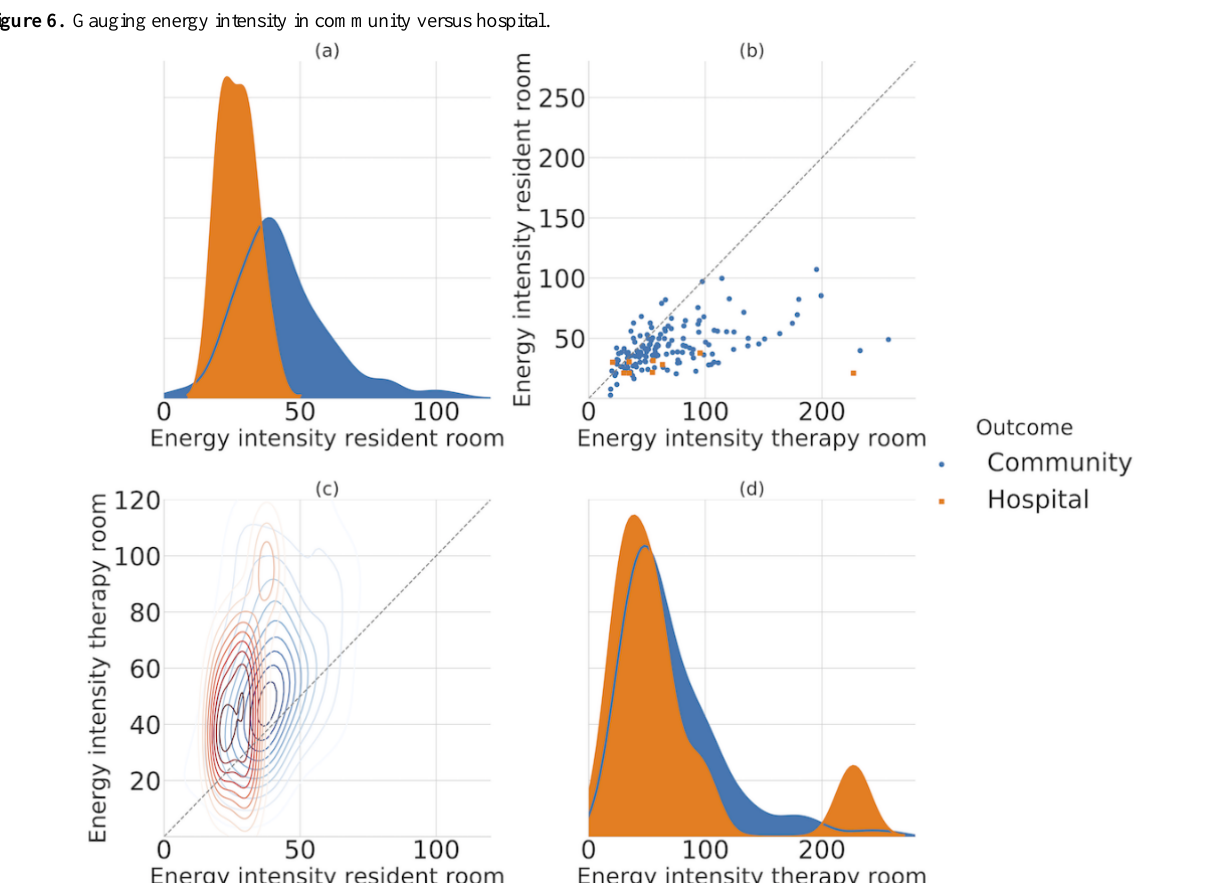
Figure 6. Gauging energy intensity in community versus